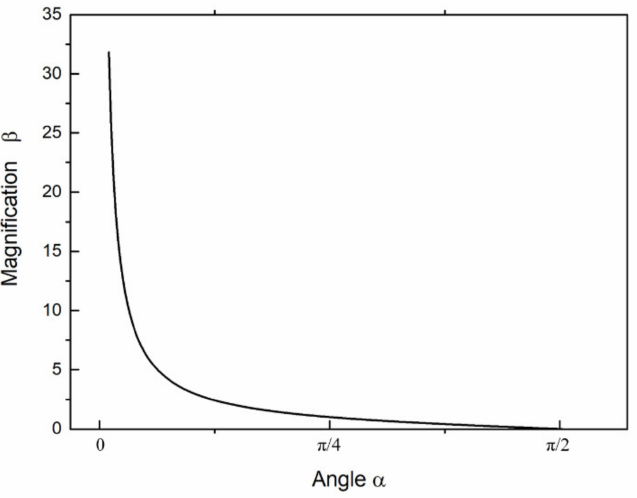
Figure 3. The relationship between the magnification and